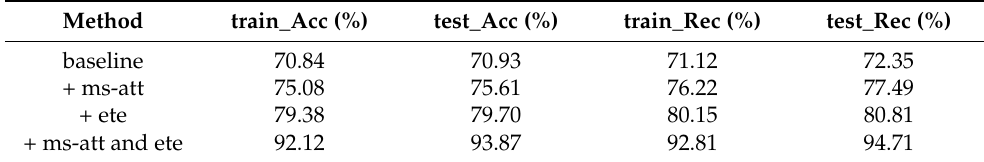
Table 3. Display of contrast results of ablation